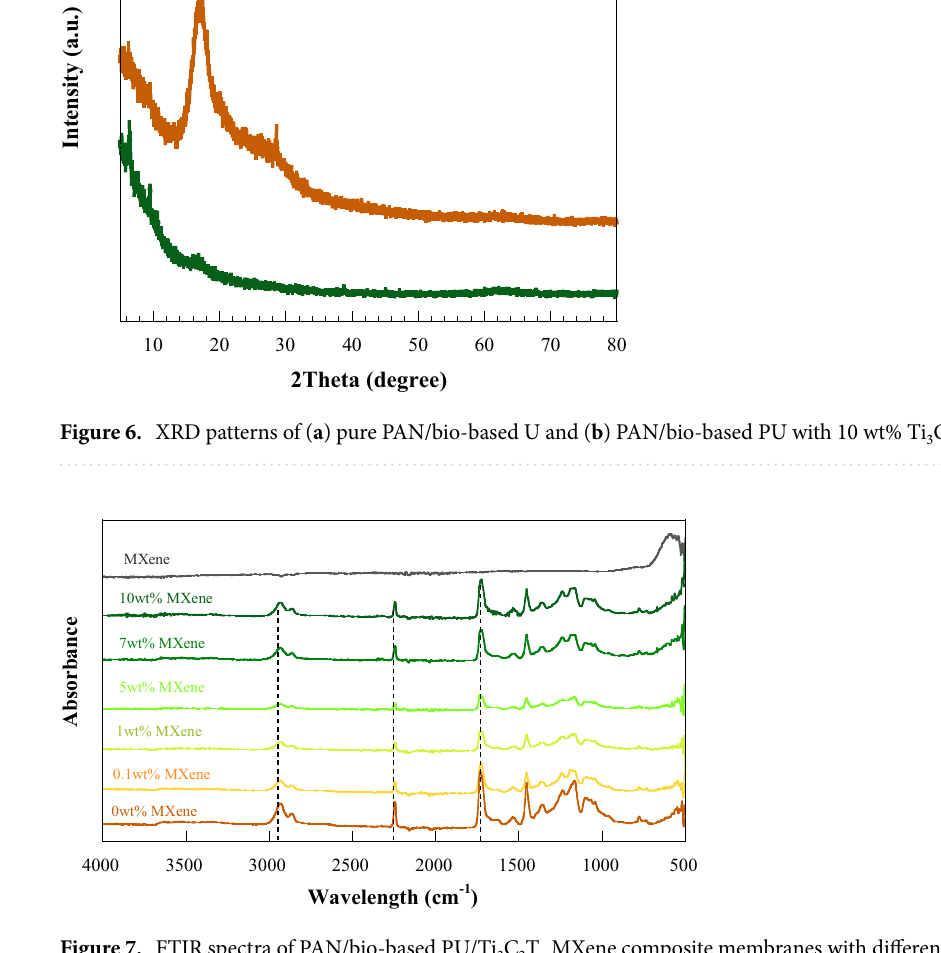
Figure 7. FTIR spectra of PAN/bio-based PU/Ti 3 C 2 T x MXene composite membranes with different Ti 3 C 2 T x MXene